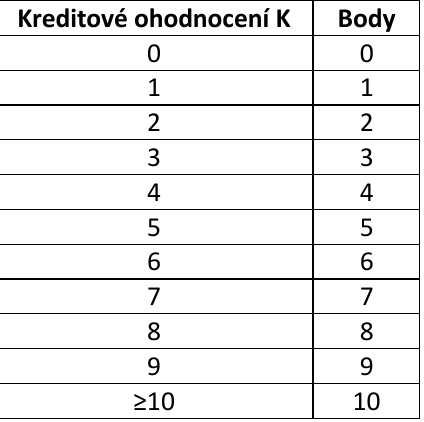
Tabulka 5: Kriteriální meze pro kritérium facility management (zdroj: autor) Kreditové ohodnocení K